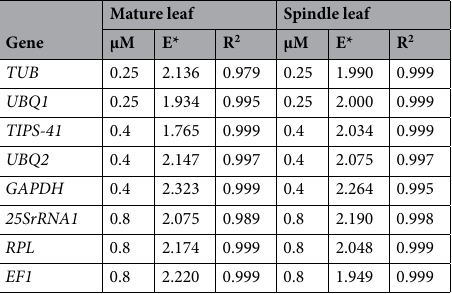
Table 1. Candidate reference genes with their respective best primer concentration, Efficiency (E) and correlation coefficient (R 2 ) in pooled mature or spindle leaf cDNA